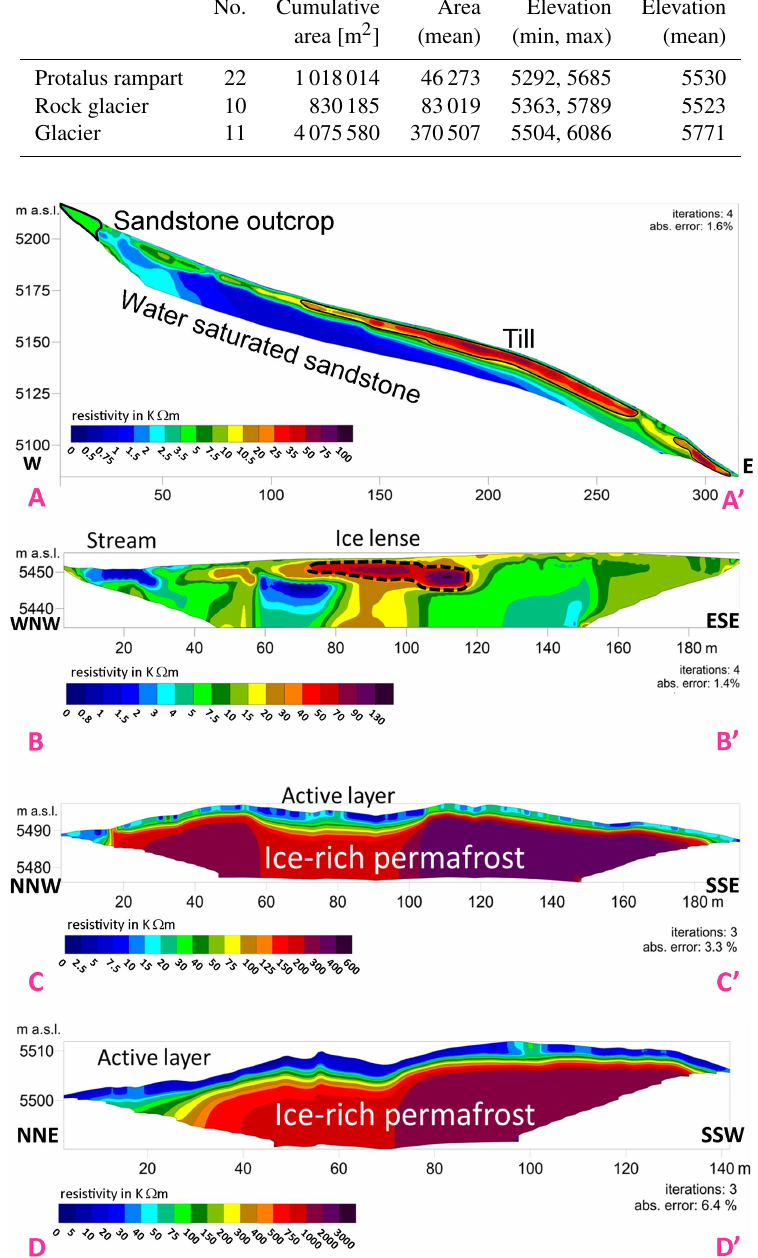
Figure 8. Electrical resistivity sections along the four ERT profiles recorded in July 2018 with a standard spacing of 2m. Profiles C and D are located on rock glacier no. 1. Note the increasing elevation between profiles A and